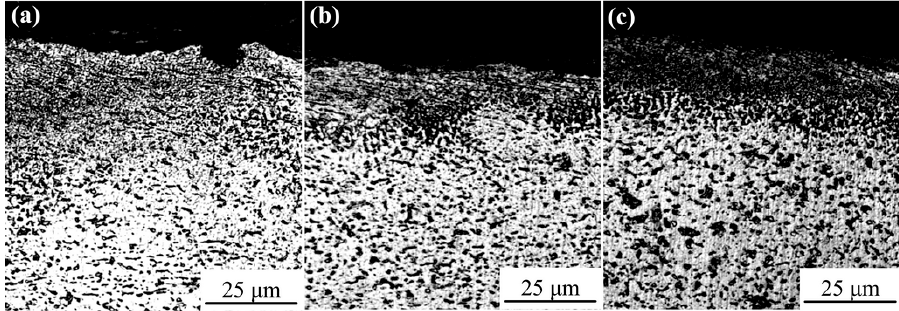
Figure 14. Profile morphologies of the untreated samples at ( a ) 250 r/min, ( b ) 478 r/min and ( c ) 637 r/min. Profile morphologies of UIRP samples are shown in Figure 15. The tribo-layer on the surface of the UIRP sample at 250 r/min is not compact enough and easily peeled off, shown as Figure 15a. The tribo-layer generated at 478 r/min in Figure 15b is thicker with an obvious vortex in the worn subsurface, and it can be seen that plastic deformation also occurs on the subsurface. The tribo-layer generated at 637 r/min in Figure 15c is compact and continuous with considerable thickness.